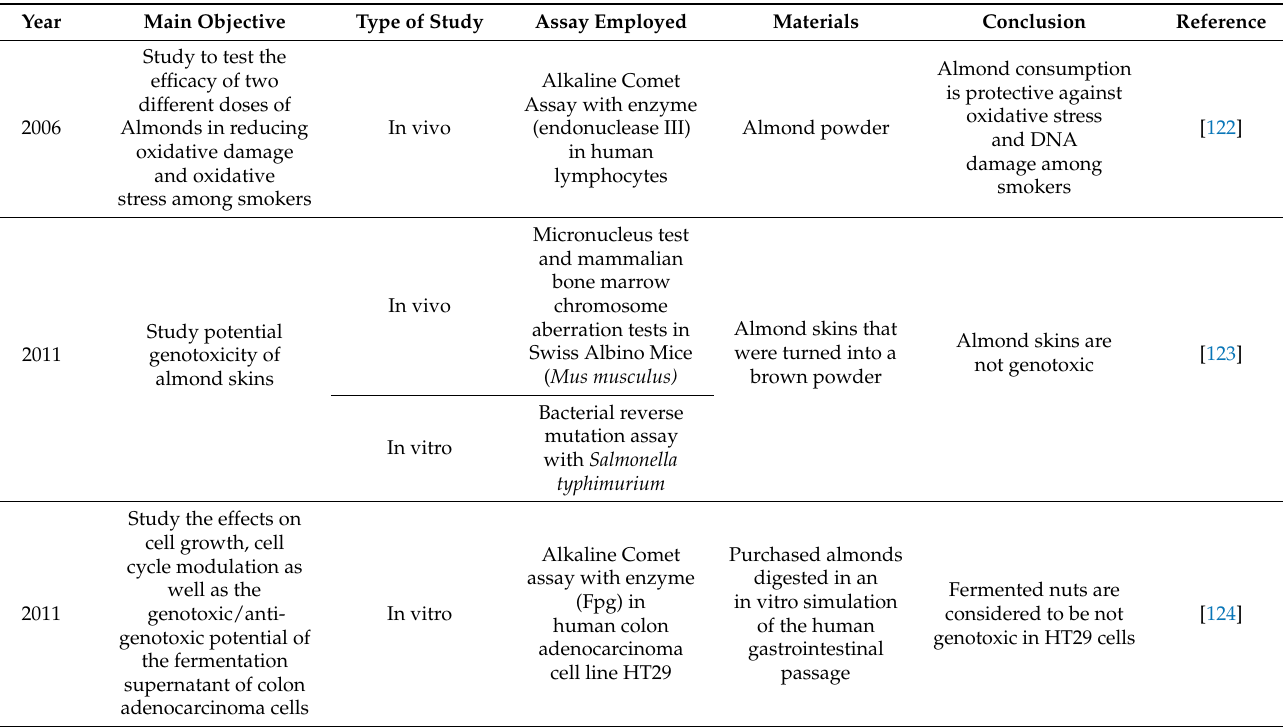
Table 4. Relevant studies of